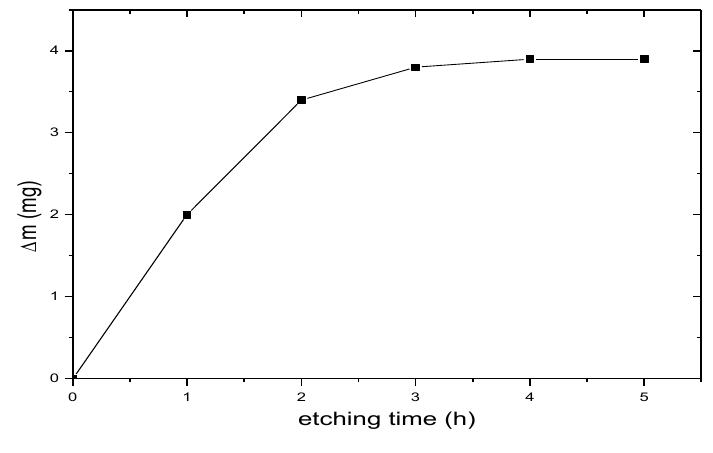
Fig.1. Evolution of the dissolved mass with the etching